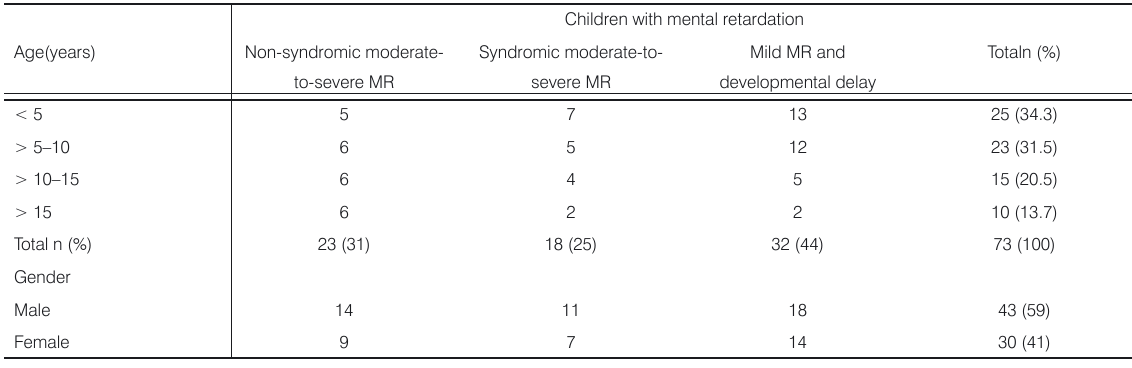
Table 3. Age and Gender of Children with Mental Retardation in Village K.